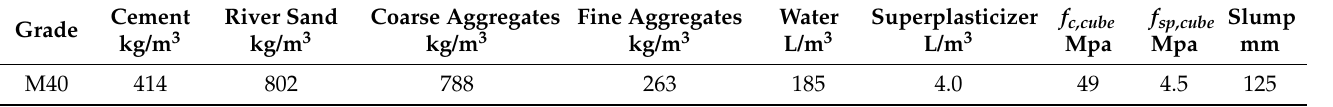
Table 1. Mix design and mechanical properties of concrete.